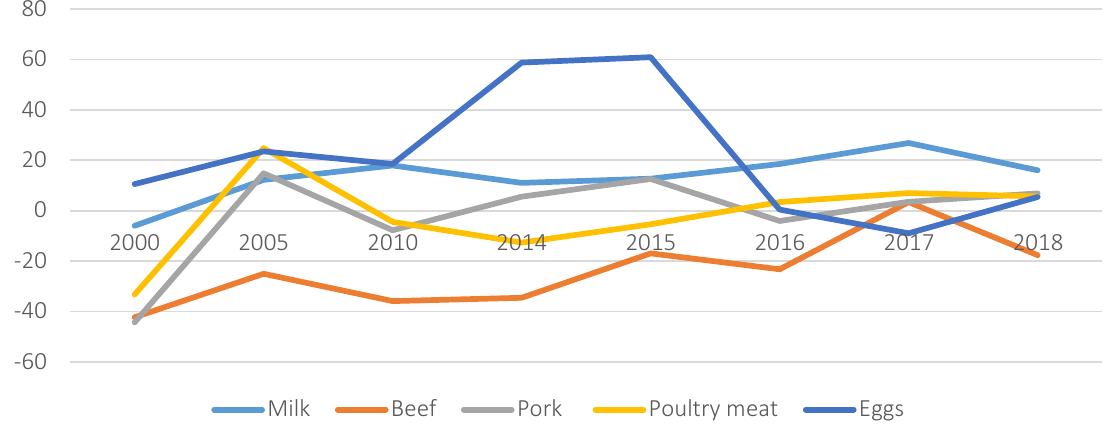
Figure 3. Dynamics of profitability of the main animal products in Ukraine, %